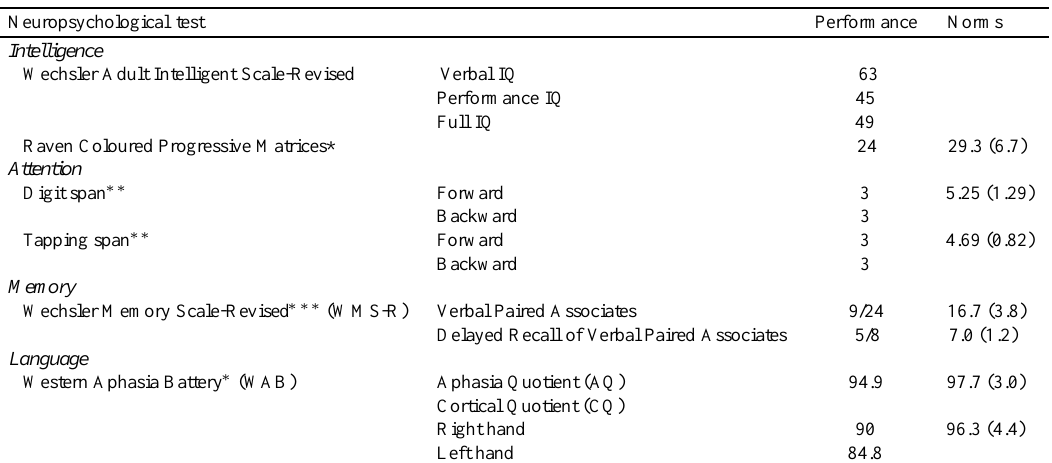
Table 1 General neuropsychological